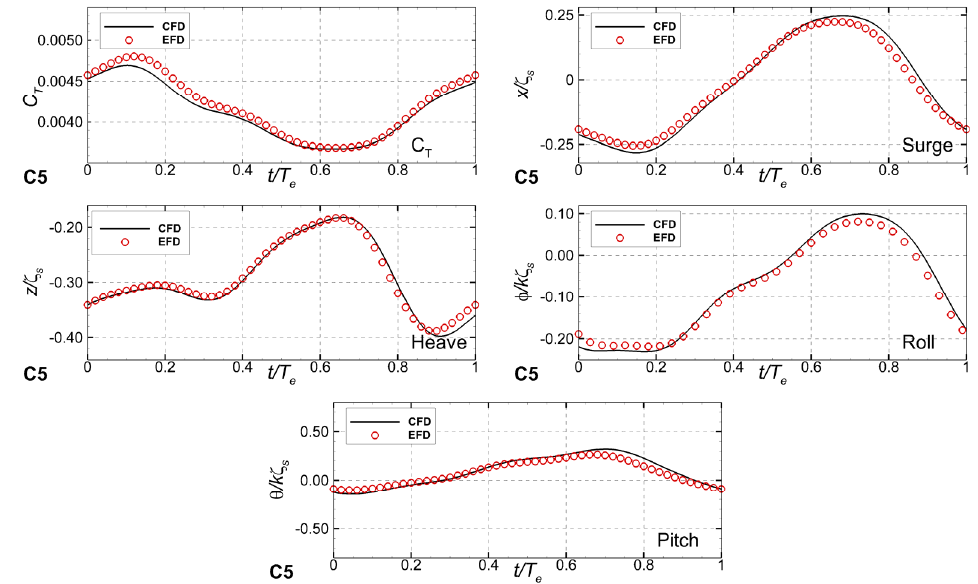
Figure 28. Comparisons between the time histories of the reconstructed resistance coefficient ( C T ) , surge ( x ) , heave ( z ) , roll ( ϕ ) , and pitch ( θ ) measured (EFD) [33], and computed (CFD) over a period of the encounter in the FRxz ϕθ following waves scenario. Table 29. Added resistance in waves computed for 𝐻 (cid:3020) = 0.045 and 𝐹𝑟 = 0.26 .